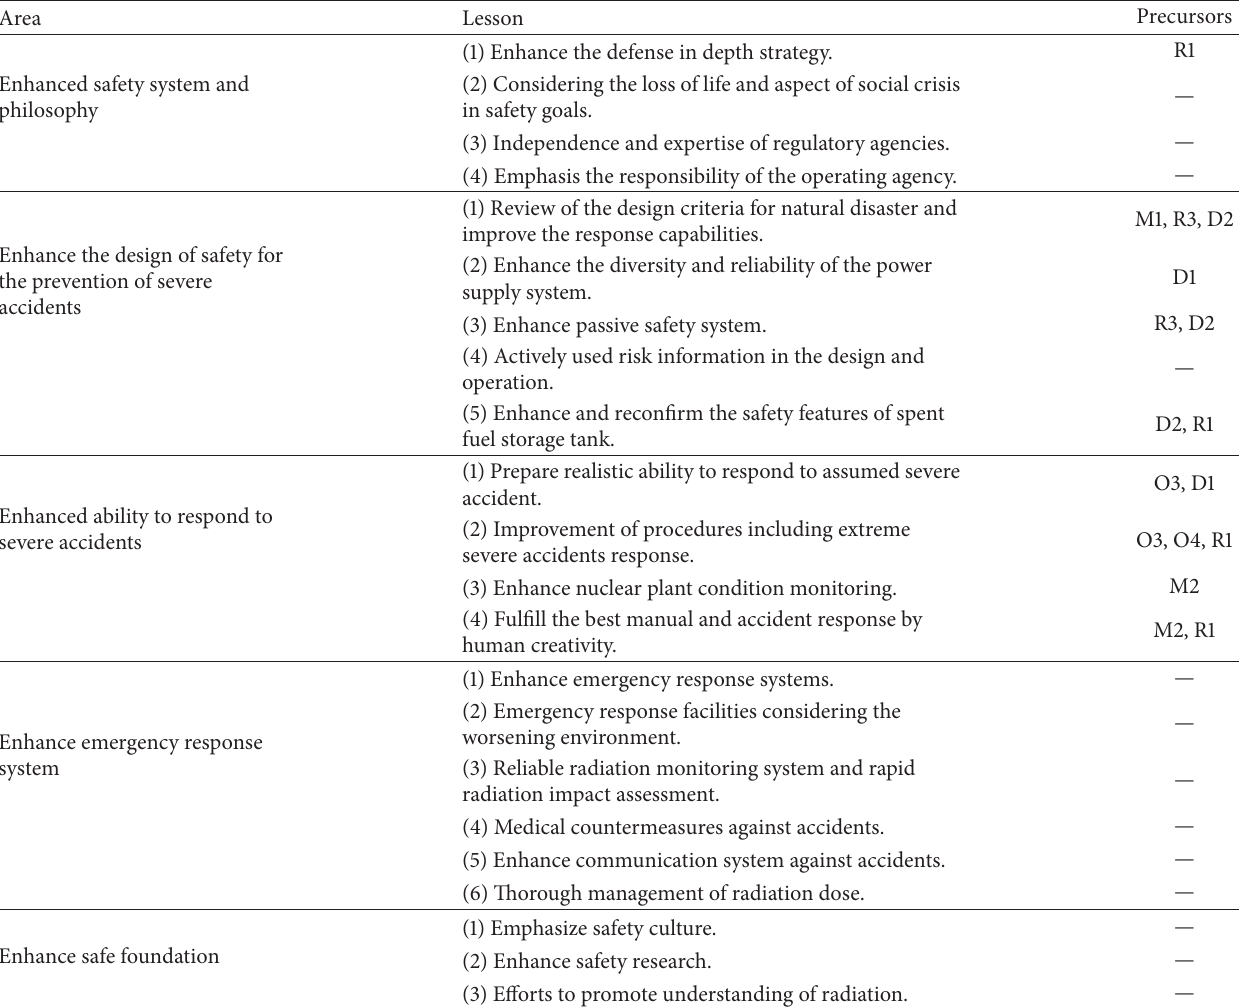
Table 13: Lesson learned from Fukushima